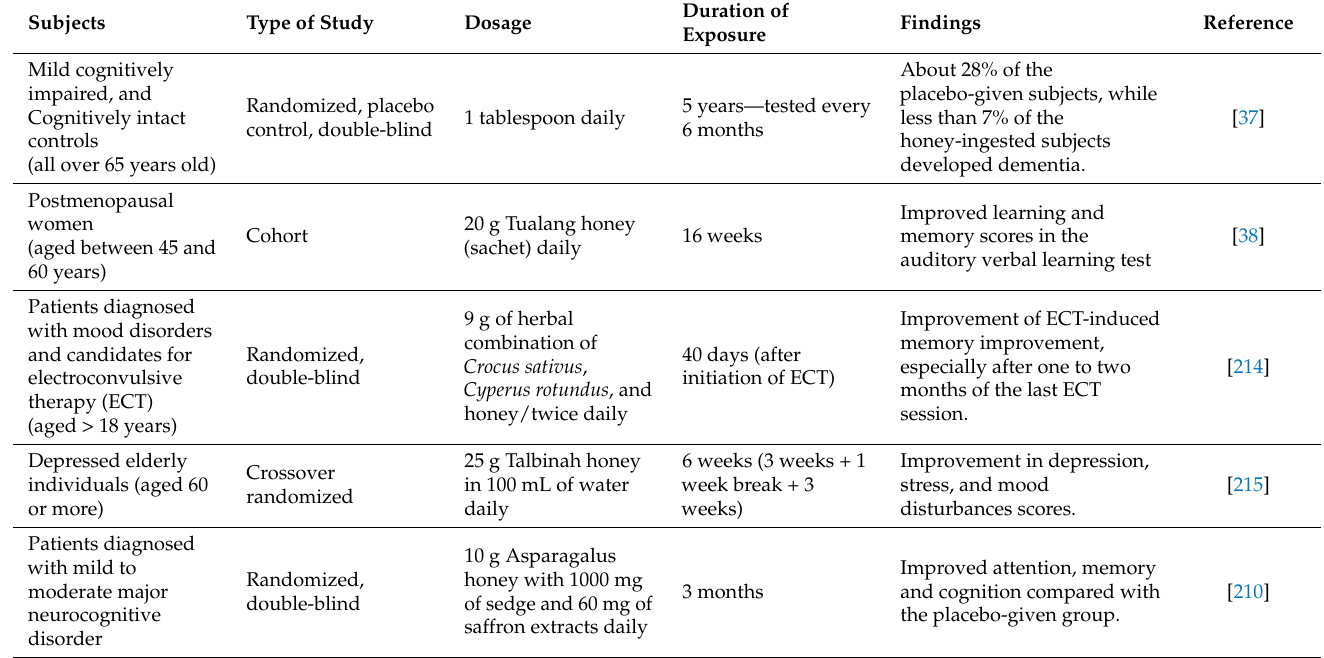
Table 4. Effects of honey consumption on memory and cognition in